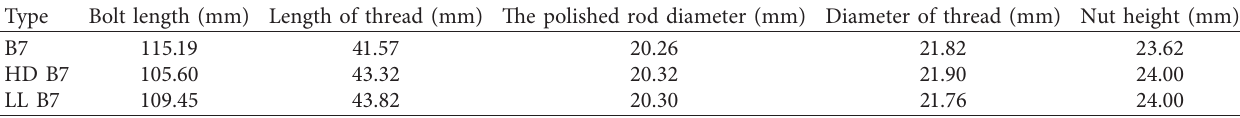
Table 1: Dimensions of four-way flange connection bolts.